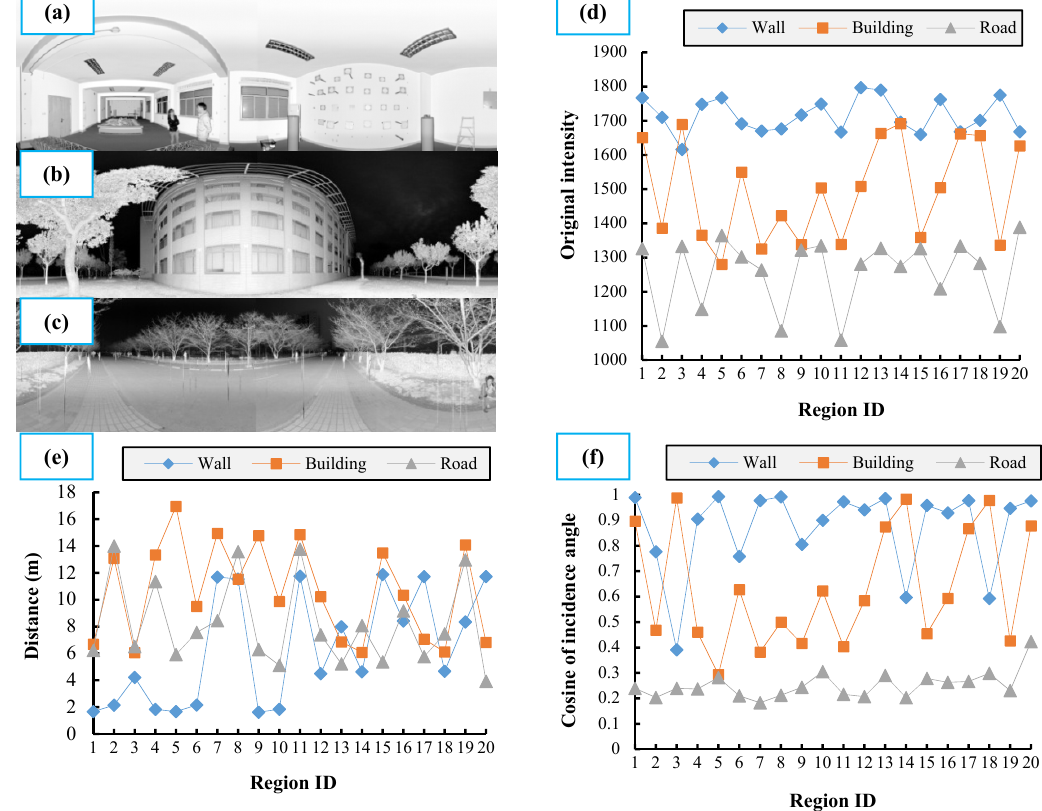
Figure 7. ( a ) Original intensity image of the white lime wall; ( b ) Original intensity image of the building facade with gray bricks; ( c ) Original intensity image of the cement road; ( d ) Original intensity values of the sampled regions of the three surfaces; ( e ) Distances of the sampled regions of the three surfaces; ( f ) Cosine of incidence angles of the sampled regions of the three